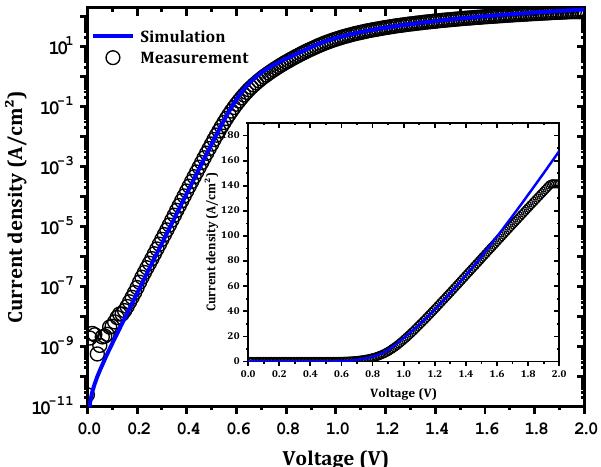
Figure 2. Comparison between the simulation data and experimental measurements. The inset is a linear representation of the J—V characteristics.